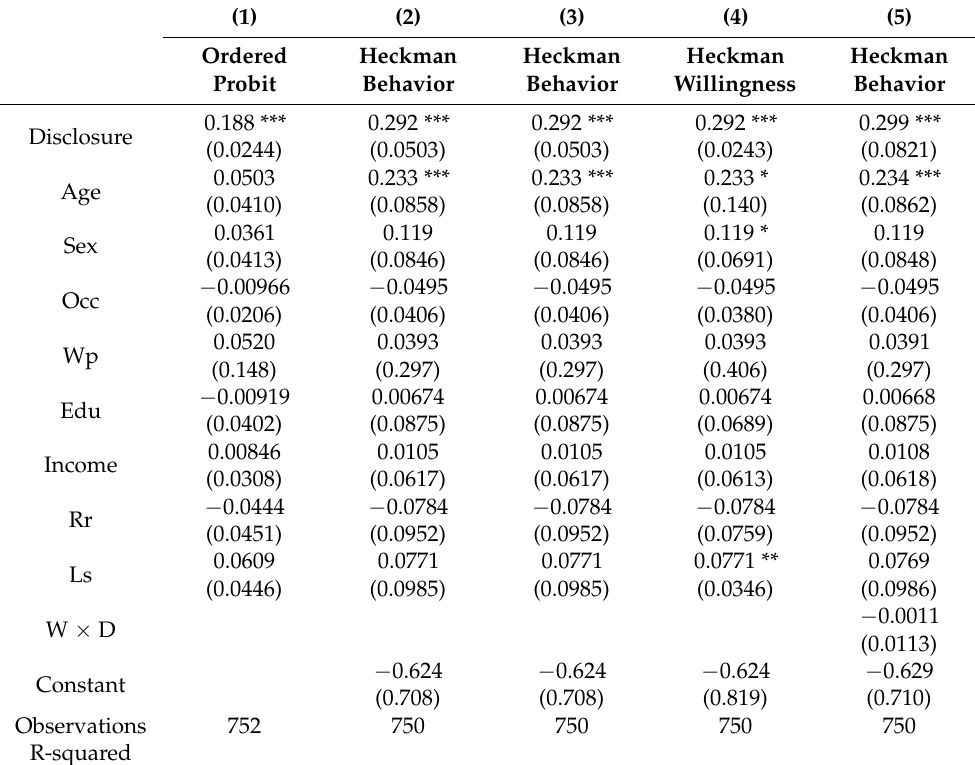
Table 5. Robustness tests for changing the benchmark regression into the probit model and the Heckman